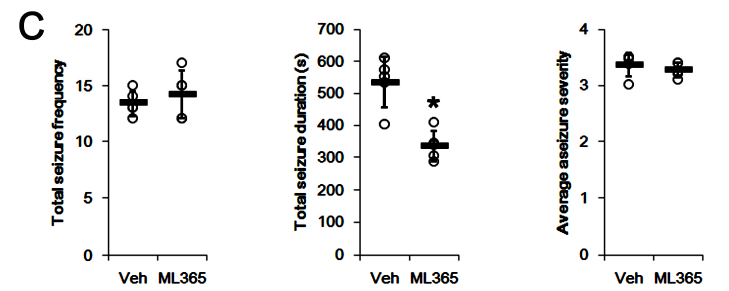
Figure 5. The effects of ML365 on spontaneous seizure activities in non-responders to perampanel (PER). ML365 decreases seizure duration, but not its frequency and severity. ( A ) Representative electroencephalograms (EEG) in each group at 4 days after treatment. ( B ) Quantitative analyses of the chronological effects of PER on seizure frequency, seizure duration and seizure severity (seizure score) over the 7-day period. Error bars indicate SD (* p < 0.05 vs. vehicle (Veh)-treated animals). ( C ) Quantitative analyses of total seizure frequency, total seizure duration and average behavioral seizure score (seizure severity) in the 7-day period. Open circles indicate each individual value. Horizontal bars indicate the mean value. Error bars indicate SD (* p < 0.05 vs. vehicle (Veh)-treated animals).